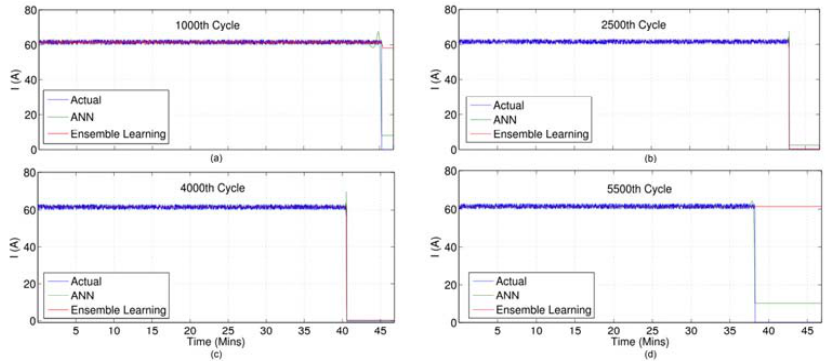
Figure 15. The impact of increasing the sample size to one sample/second. ( a ) 1000th Cycle; ( b ) 2500th Cycle; ( c ) 4000th Cycle; ( d ) 5500th Cycle.